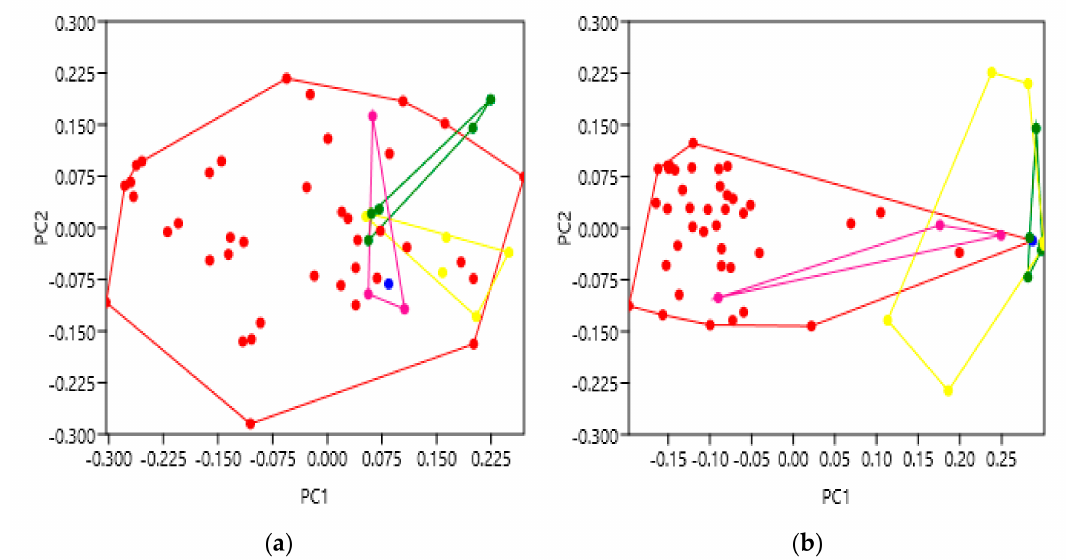
Figure 4. Principal component analysis to show the family B receptor shape variation due to bound ligands. Agonist-bound structures are red, antagonist yellow, negative allosteric modulator (NAM) green, partial agonist blue and unbound purple. ( a ) PC score comparison for the extracellular face of the family B transmembrane bundle. ( b ) PC score comparison for the intracellular face of the family B transmembrane bundle. The supporting statistical data are summarised in Tables 4 and 5. Additional supporting figures are found in Appendix B Figure